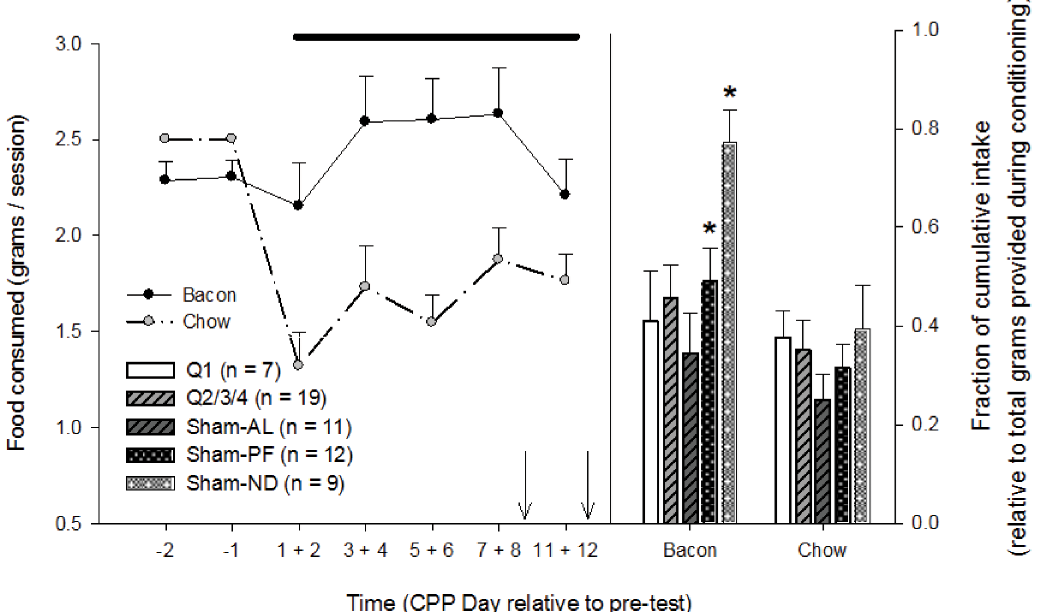
Fig 6. Food intake throughout the conditioning sessions. Animals were given 10-minutes to consume 5-grams of either bacon or chow during the final 10 min of each conditioning session. Irrespective of group, animals consumed more bacon than chow throughout the conditioning-component, suggesting that relative to chow, bacon was highly palatable. Cumulative intake is the sum grams consumed between CPP days 1 and 12 for each food-stimulus (arrows indicate Test Days 1 and 2; thick line: p < 0.05 for bacon versus chow on the given days; * p < 0.05 for bacon versus chow in a specific group). The only significant differences observed were found between bacon and chow (Sham-ND and Sham-PF).